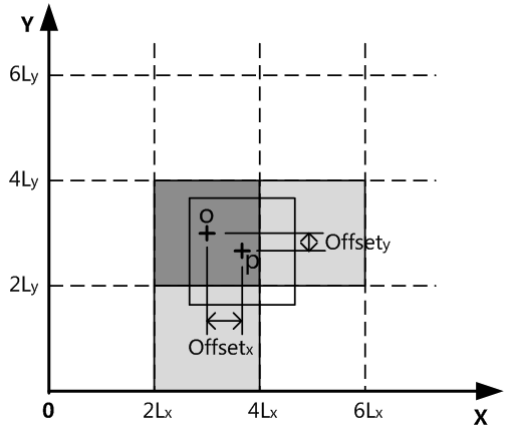
Figure 4. In the improved calculation method, in two-dimensional space, the contribution of data point P is calculated.